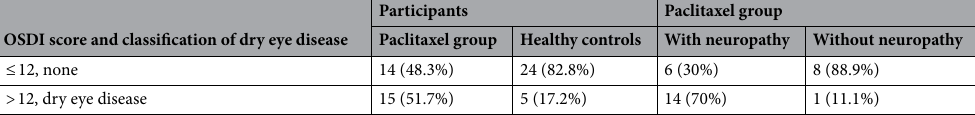
Table 1. Prevalence of ocular discomfort associated with dry eye disease in all participants and amongst paclitaxel-treated patients with and without neuropathy. OSDI, Ocular Surface Disease Index.